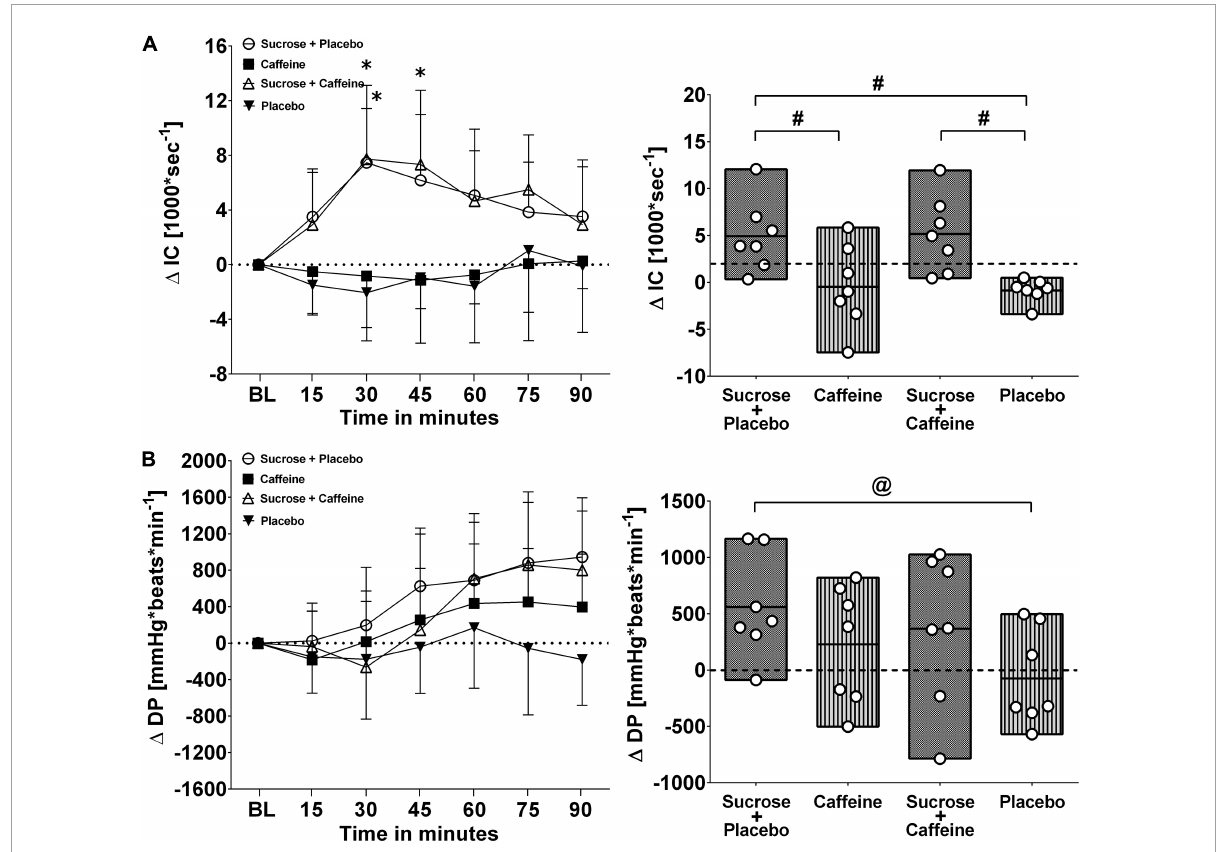
FIGURE4 Left panels (A,B) : Time course for changes in index of contractility (IC) and double product (DP) in response to the four drinks. Each mean value (i.e., 15-min blocks) corresponds to the average over the respective interval that was subtracted by its baseline (BL) values. Data are presented as means ± standard deviation. Right panels (A,B) : Boxes (minimum to maximum values) represent individual mean responses (open circles) averaged over 90 min post-drink and subtracted by baseline values for each drink, respectively. In both panels, asterisks show statistically significant differences over time from baseline values (both panels) at ∗ p < 0.05. For right panels only, # p < 0.05 and @ p < 0.01 represent statistically significant differences between responses to the drinks as analyzed by one-way repeated measures analysis of variance with Holm–Sidak’s post hoc